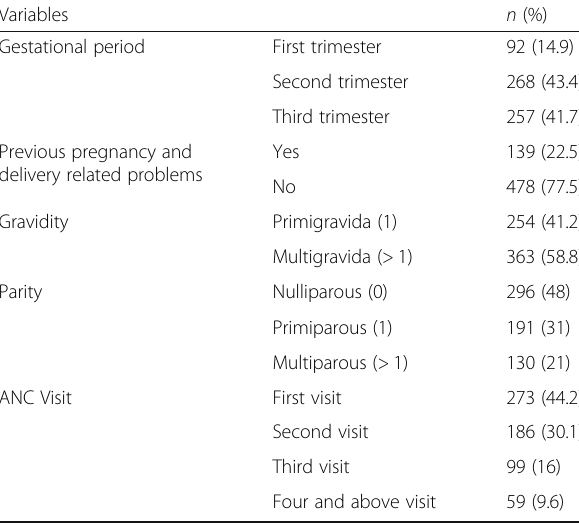
Table 2 Obstetric factors of pregnant women, Addis Ababa,